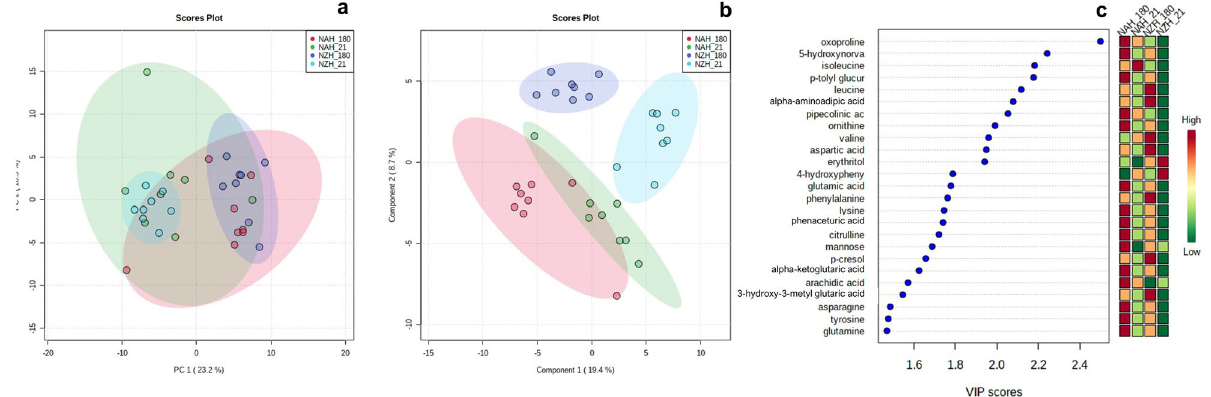
Figure 1. Scores plot for PCA ( a ), PLS-DA ( b ) of North American (NAH, n = 8) and New Zealand (NZH, n =8) Holstein cows under grazing conditions at 21 (green and sky-blue dots, respectively) and 180 (red and purple dots, respectively) days in milk. The VIP scores plot ( c ) is based on the top 25 metabolites with the highest VIP values for the 1st component of PLS-DA. Green to red color denote low to high plasma concentrations of the current metabolite.